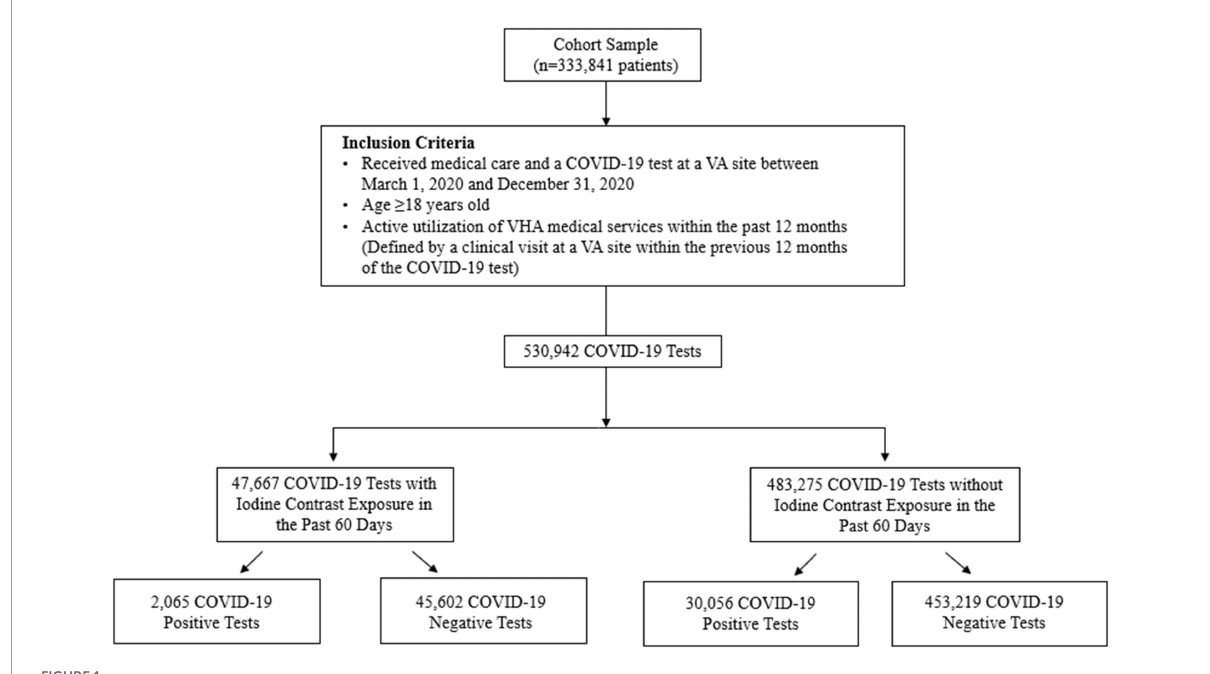
FIGURE1 Flow of study sample